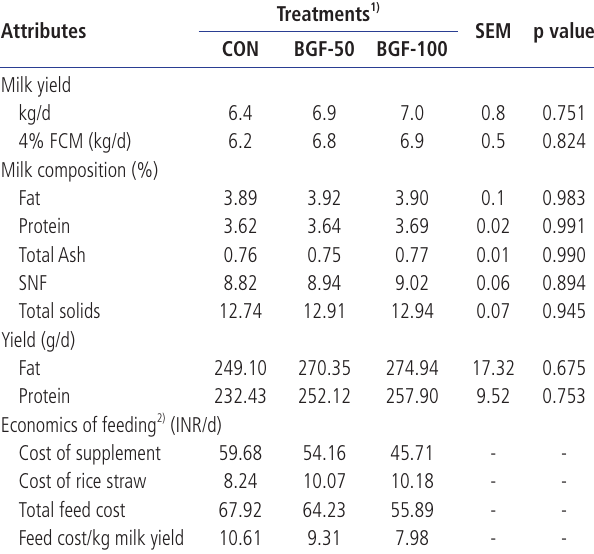
response to supplementation with different sources of carbo­ hydrates. Crop and Pasture Sci 2000;51:393­400.